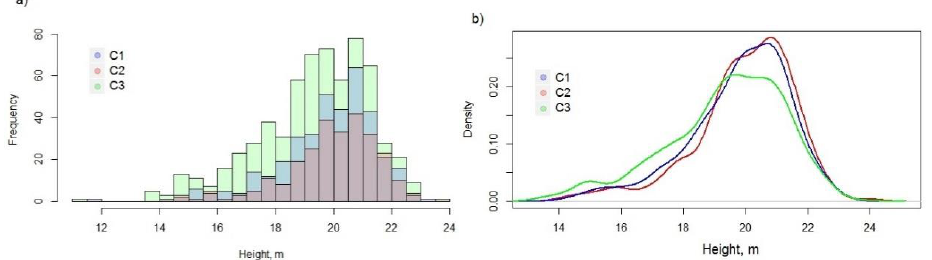
Figure 7. Histograms of height distribution of single returns for C1, C2, and C3 over LP plot ( a ), and corresponding kernel densities ( b ). Table 9. Results of Kolmogorov-Smirnov test D values ( p -value in brackets) for returns higher than 10 m above ground (in the upper-right), and returns higher than 19 m above ground (in the lower- left).